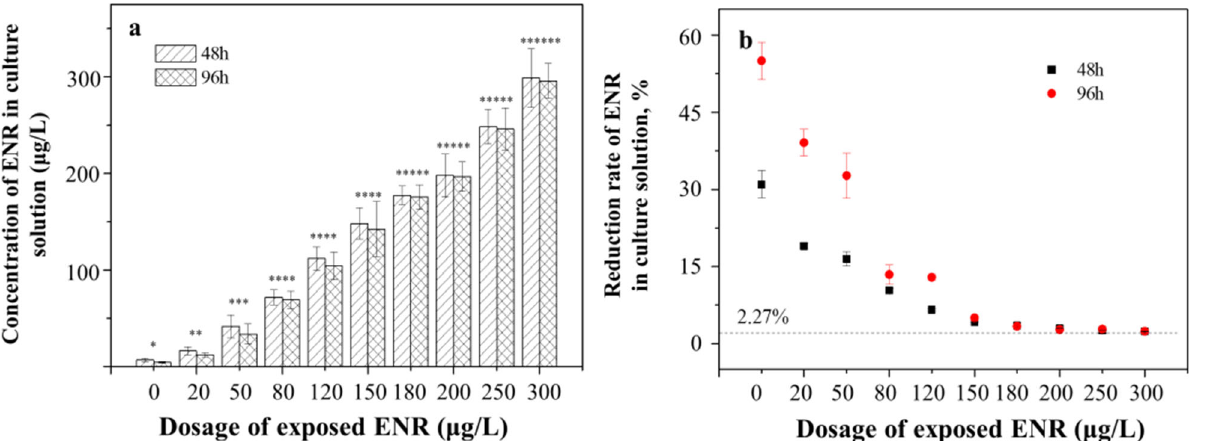
Figure 1. The residual ( a ) and rate of reduction in ( b ) ENR concentrations in the algae culture solution under different exposure dosages at 48 h and 96 h. The number of “*” was referred as the significant between-group variance. The same number means no significant difference, whereas the different number means the significant